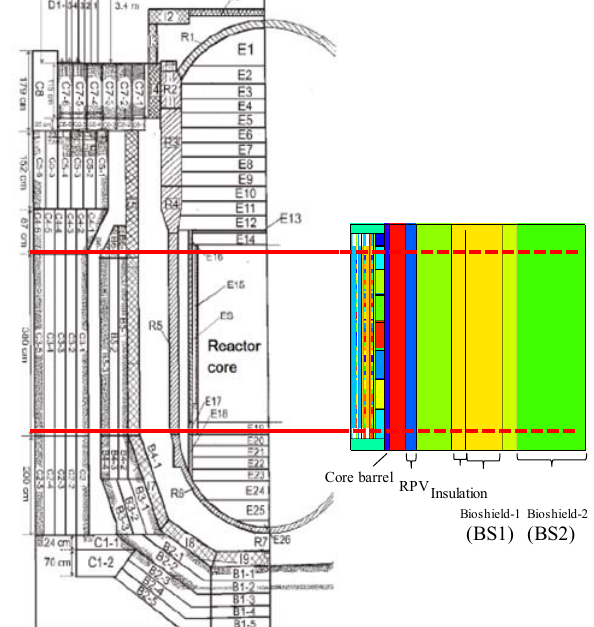
Figure 3. An illustration on the axial cross-section of the employed MCNP PWR